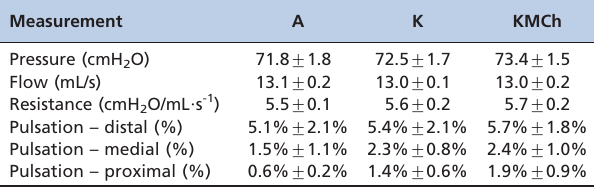
Table 3 - RECEL group